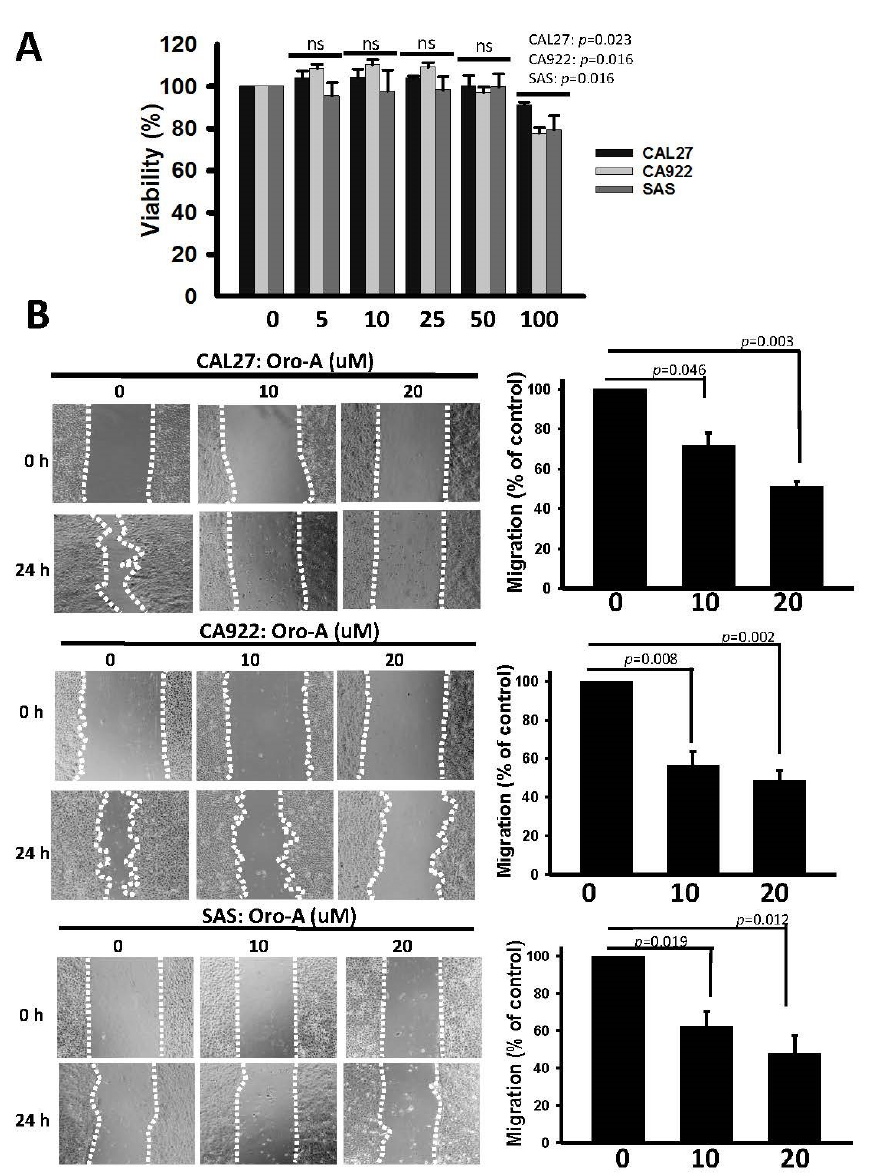
Figure 1. Effect of Oro-A exposure on the migration activity of oral squamous cell carcinoma (OSCC) cells. ( A ) CAL27, CA922, and SAS cells were treated with the vehicle control (dimethyl sulfoxide, DMSO) or Oro-A (0–100 µ M) for 72 h, and relative survival was assessed with a sulforhodamine B (SRB) assay. ( B ) OSCC cells were treated with vehicle (DMSO) or Oro-A (10 and 20 µ M) for 24 h, and the migration activity of cells was determined with a wound healing assay. All experiments were performed at least three times. P values were determined using Student’s t test. Ns: not